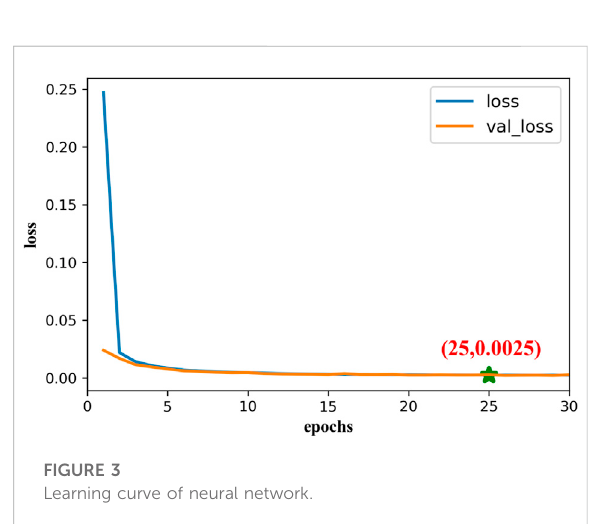
FIGURE 3 Learning curve of neural